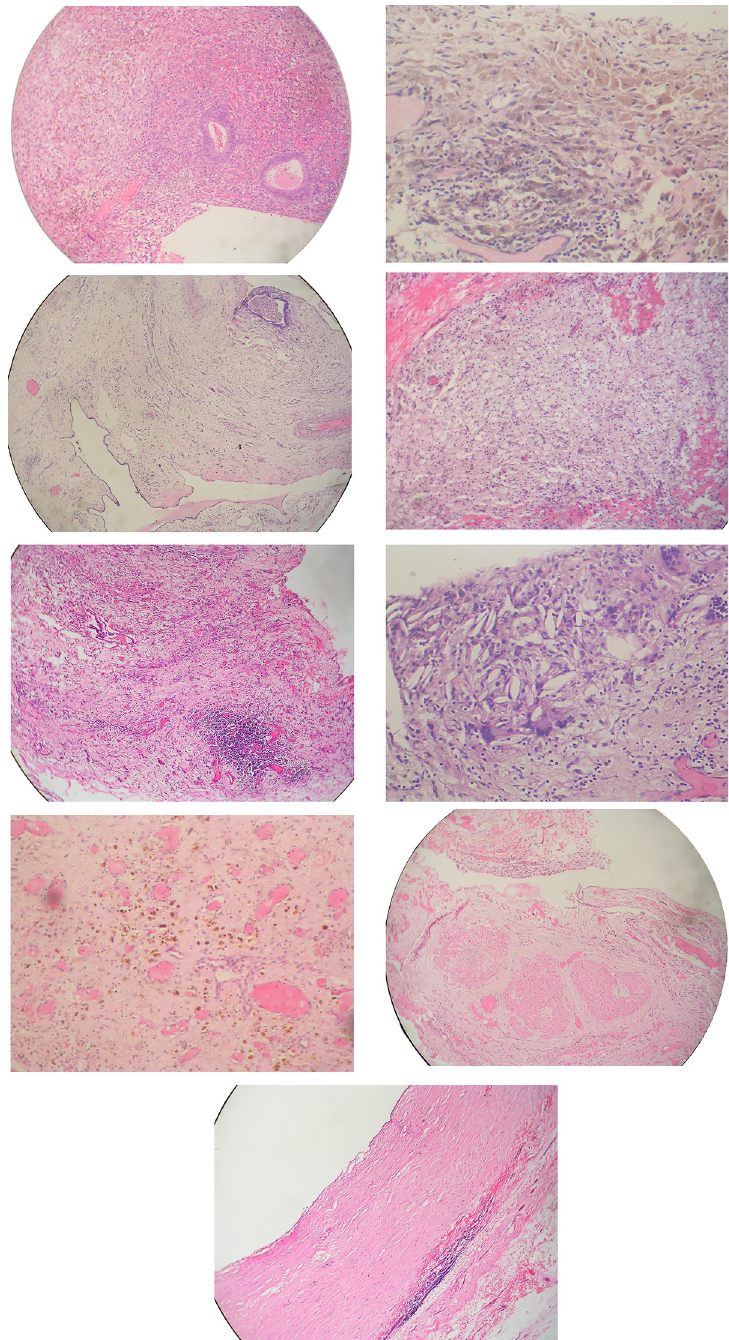
Fig 1. A: Typical thoracic endometriosis simulating native proliferative endometrium. H&E staining, original magnification X300. B: Dilated endometrioid gland with intraluminal pseudoxanthoma cells; the surrounding stroma is inconspicuous. H&E staining, original magnification X150. C: Lymphocytic aggregate and dilated and congested blood vessels in oedematous nonspecific stroma; a distorted endometrioid gland is also present. H&E staining, original magnification X100. D: Oedematous hyalinised stroma with congested capillaries and siderophages with golden- brown pigments. H&E staining, original magnification X300. E: Ceroid macrophages with brownish finely granular cytoplasm. H&E staining, original magnification X300. F: Foamy macrophages in the stroma. H&E staining, original magnification X150. G: Cholesterol crystals and multinucleated foreign body-type giant cells. H&E staining, original magnification X300. H: Bundles of smooth muscle cells. H&E staining, original magnification X150. I: Pleural fibrosis. H&E staining, original magnification X150.